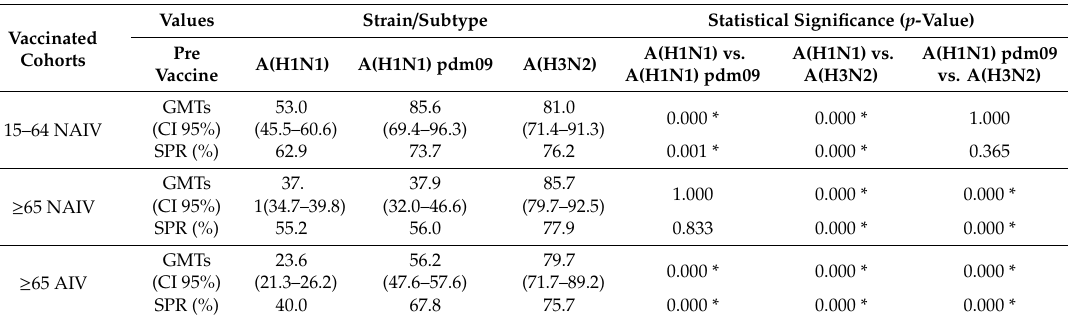
Table 1. Protection presented by each cohort before vaccination in terms of the geometric mean titers (GMTs) and seroprotection rate (SPR) against each strain / subtype of influenza A. Statistical significance within each cohort, comparing all influenza A subtypes against each other. * p -values <